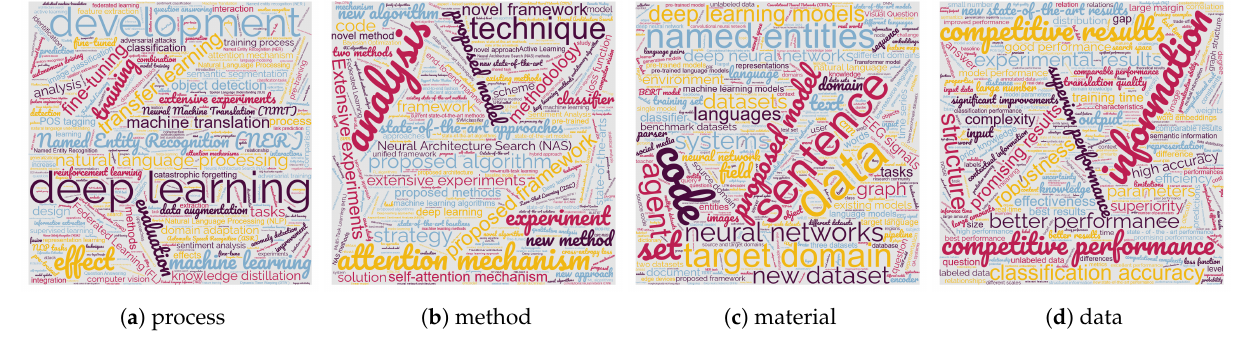
Figure 5. Computer Science domain word clouds.